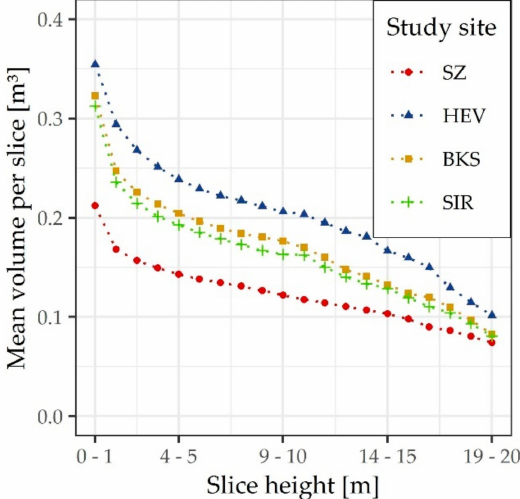
Figure 7. Vertical profile of the mean wood volume per 1 m trunk section up to a height of 20 m. SZ = Schattiner Zuschlag (long-term unmanaged), HEV = Hevenbruch (short-term unmanaged), BKS = Berkenstrücken (extensively managed), SIR = Sirksfelder Zuschlag (intensively